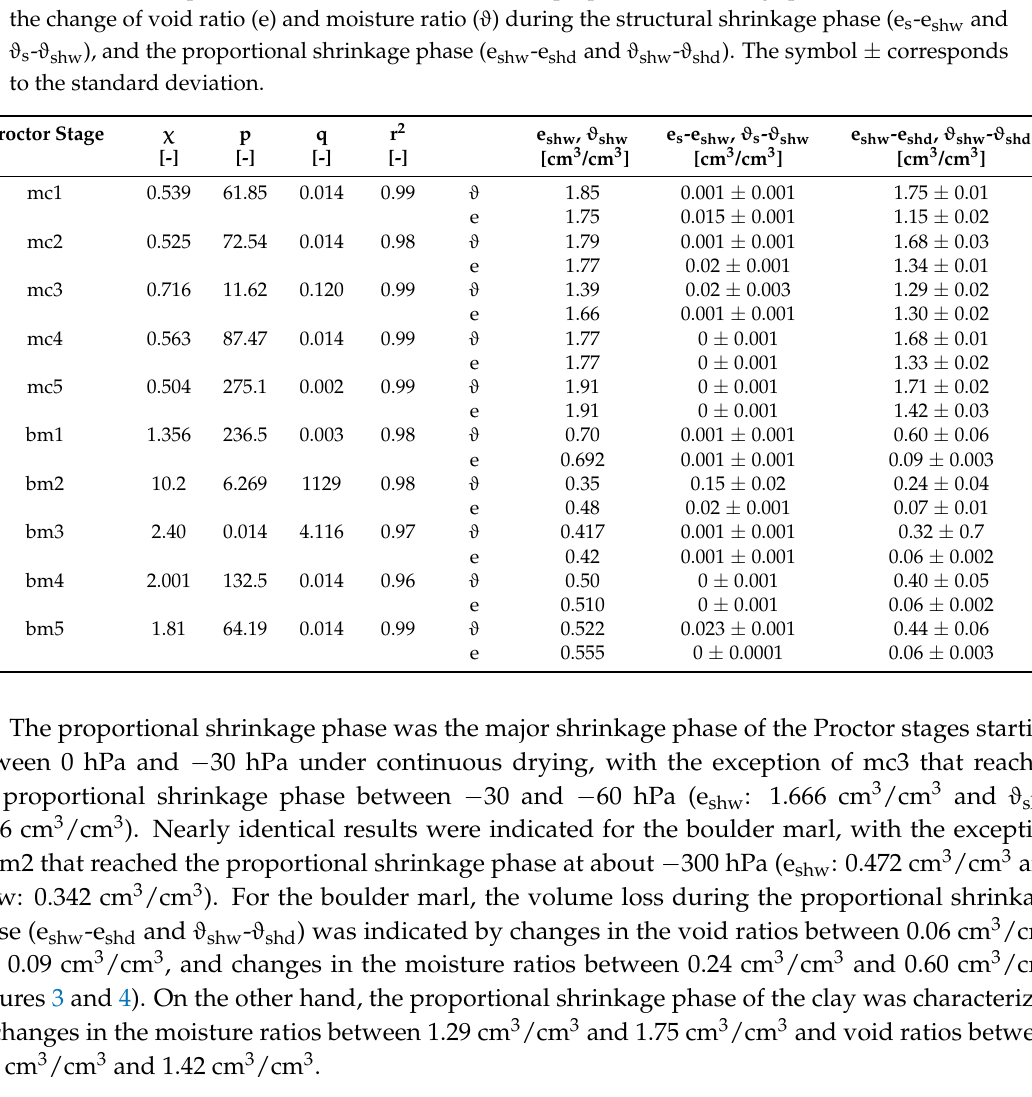
ϑ shw and shw ), ± corresponds ϑ ϑ shw - shd ). The symbol